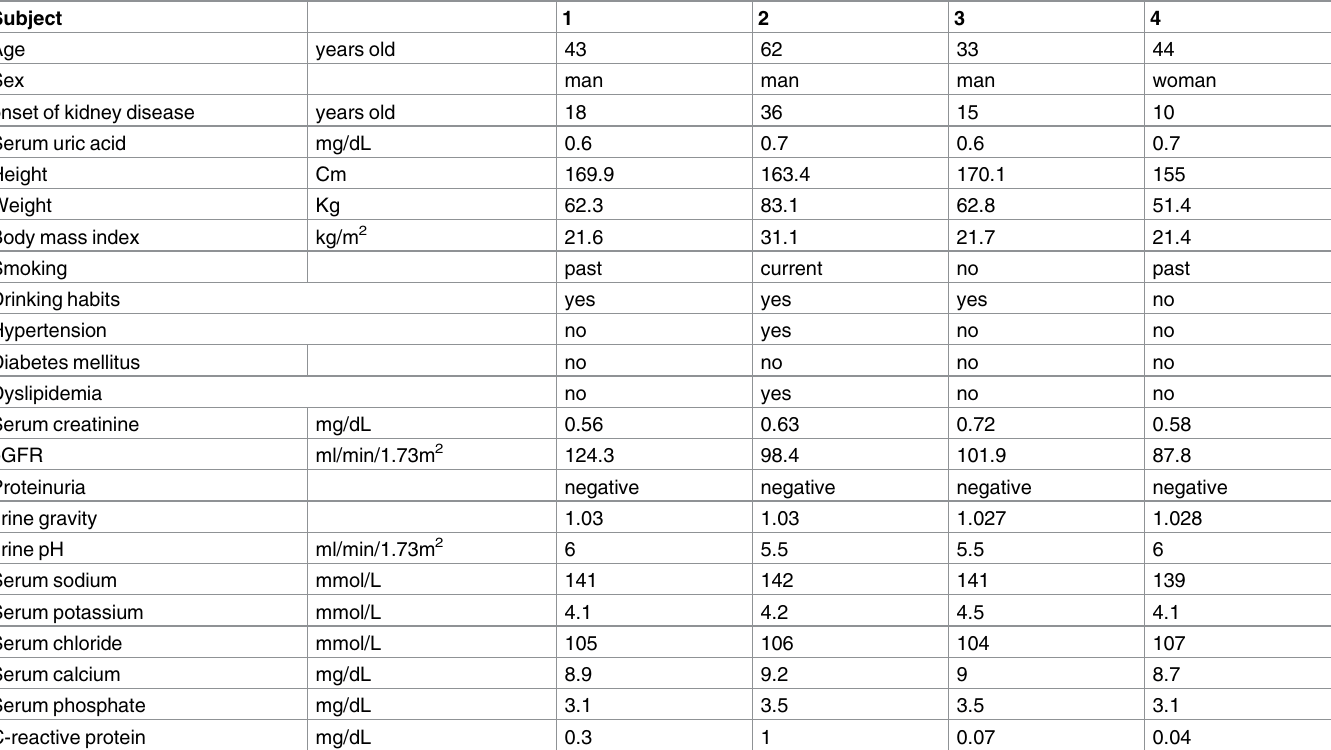
Table 4. The details of four hypouricemic subjects who had a history of kidney